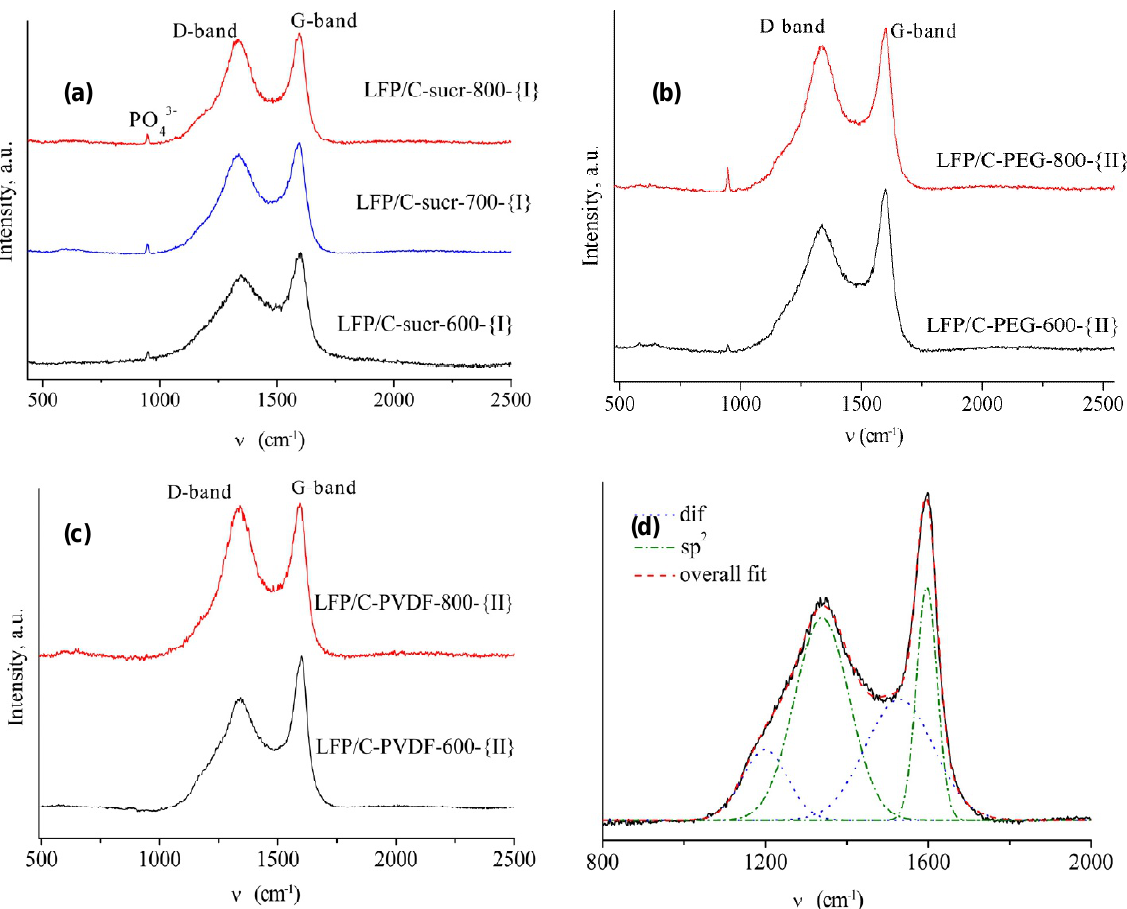
Fig. 5. ÊÕáÕâ çäÙ×èæÕ ãÚ Ä¾È¨» çÕáäàÙç ëÝèÜ Õ ×ÕæÖãâ ×ãÕèÝâÛ ãÖèÕÝâÙØ Õè ¯©© ÕâØ ±©© º» éçÝâÛ êÕæÝãéç carbon sources: sucr (a), PEG (b), PVDF (c). For the LFP/C-PVA-600-{II} sample, a spectral curve fitting is demonstrated